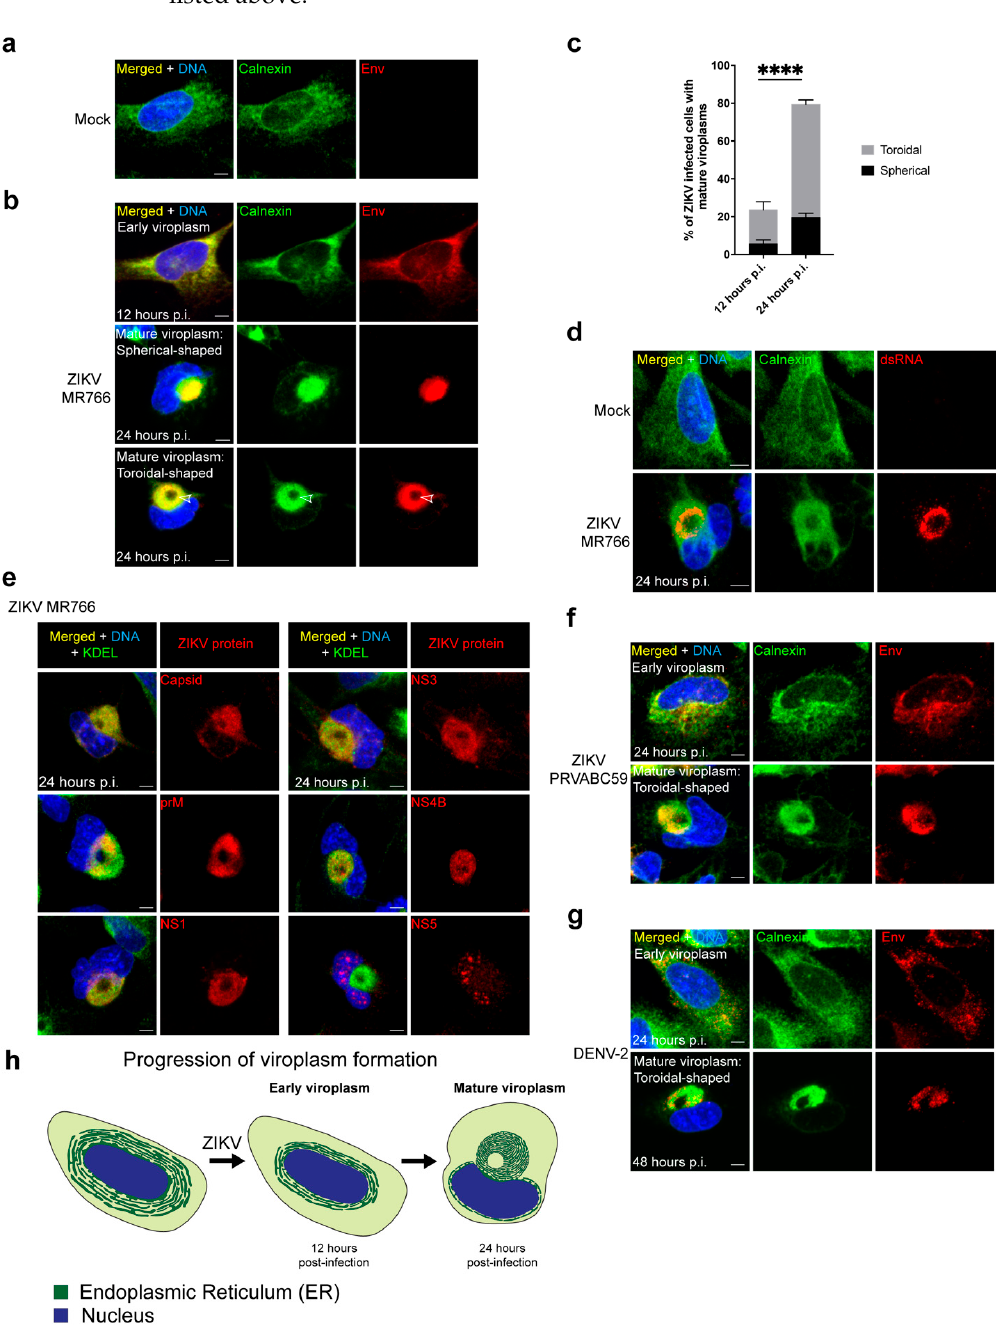
Figure 1. ZIKV forms a toroidal-shaped viroplasm: ( a,b ) Immunofluorescent (IF) staining of mock ( a ) and ZIKV-infected ( b ); Ugandan isolate (MR766) SNB19 cells fixed 12 h and 24 h post-infection (p.i.). ZIKV protein envelope (Env; red) localizes to the ER membrane marked with calnexin (green). ( b ) Upper panel shows example of an early viroplasm. Middle and bottom panels show examples of mature viroplasms that are spherical and toroidal-shaped, respectively. Arrowheads indicate the core of the viroplasm; ( c ) quantification of mature viroplasms for ZIKV infected cells at 12 and 24 h p.i. T-test comparing the frequency of mature viroplasms for the following conditions from five independent experiments (15–47